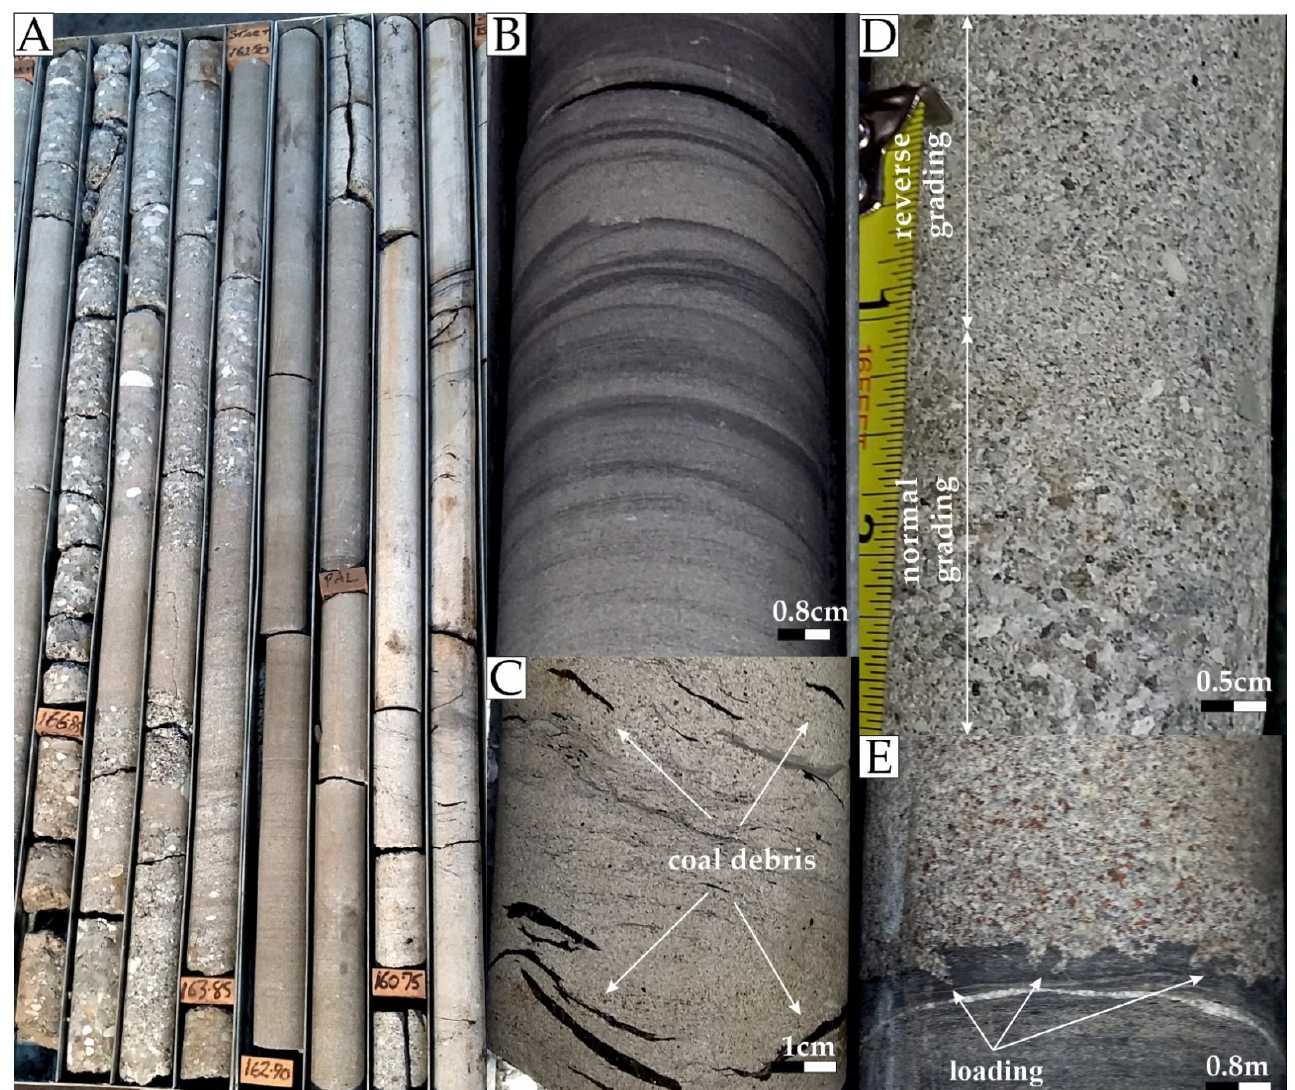
Figure 4. Core photographs illustrating sedimentological characteristics of the FA2 (upper delta-plain channels). ( A ) Clast to matrix-supported conglomerate, interbedded with structureless sandstone. ( B ) Repetitions of structureless to parallel- laminated sandstone and mudstone. ( C ) Transported coal debris in FA2. ( D ) Normally- to reverse-graded sandstone bed. ( E ) Erosional contact of FA2 with the underlying fine-grained deposits. Note the loading of sandy material in the under- lying mudstone.